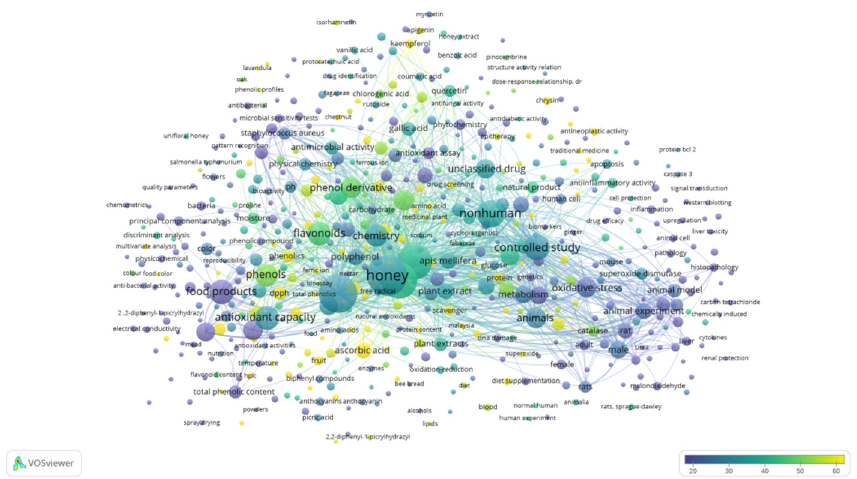
Figure 1. Term map for the relationship of honey and its antioxidant properties research. Bubble size represents the number of publications. Bubble color represents the citations per publication (CPP). Two bubbles are closer to each other if the terms co ‐ appeared more frequently (bibliometric data were extracted from the Scopus online database and elaborated by the VOSviewer software).